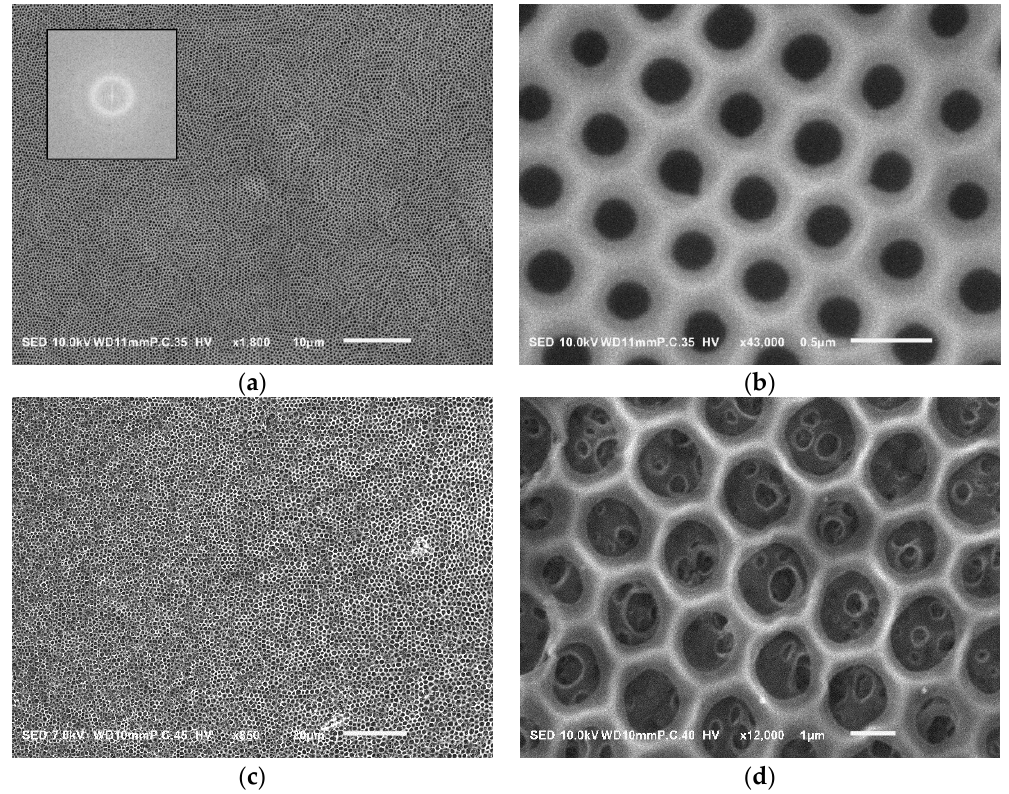
Figure 10. SEM images of BF films generated by Pd-LDBC complexes. ( a , b ) Pd-deLG1-PSt 11k, insert: FFT of the image; ( c , d ): Pd-deLG2-PSt 23k.